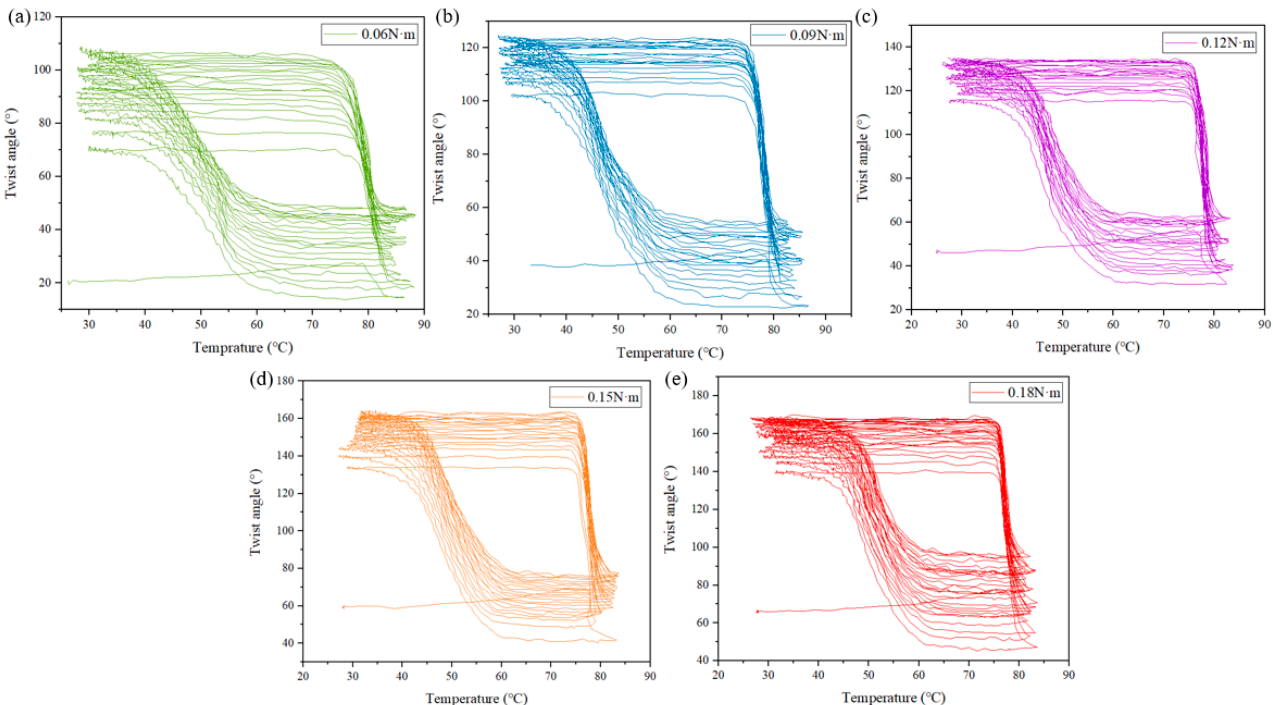
Figure 12. The twist angle–temperature responses of S3 subjected to 20 constant-torque thermal cycles. Torques are ( a ) 0.06 N·m, ( b ) 0.09 N·m, ( c ) 0.12 N·m, ( d ) 0.15 N·m and ( e ) 0.18 N·m.